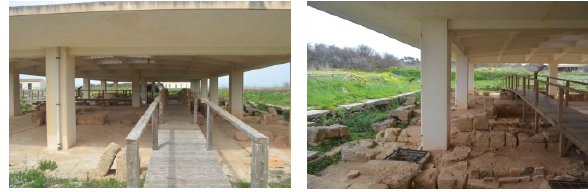
Figure 3. Wooden walkways on the Roman Domus .